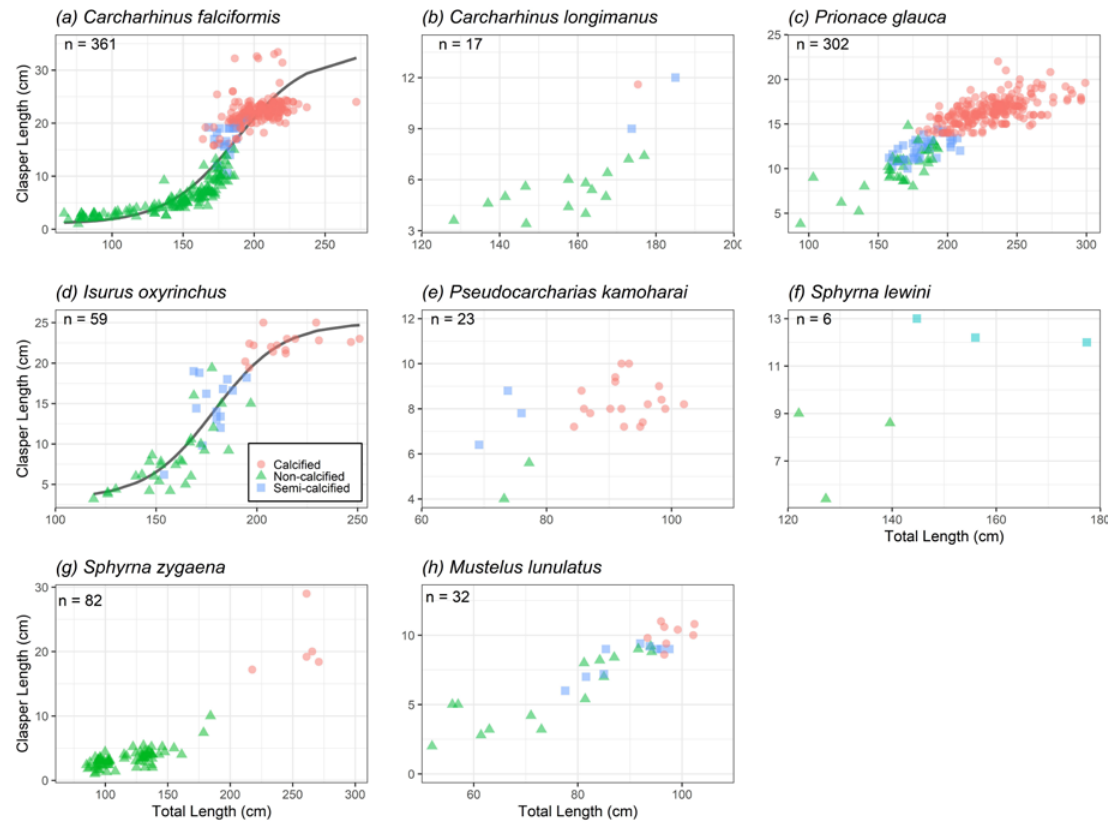
Figure 4. Relationship between the total length and the clasper length of the most abundant species: ( a ) Carcharhinus falciformis ; ( b ) Carcharhinus longimanus ; ( c ) Prionace glauca ; ( d ) Isurus oxyrinchus ; ( e ) Pseudocarcharias kamoharai ; ( f ) Sphyrna lewini ; ( g ) Sphyrna zygaena ; ( h ) Mustelus lunulatus